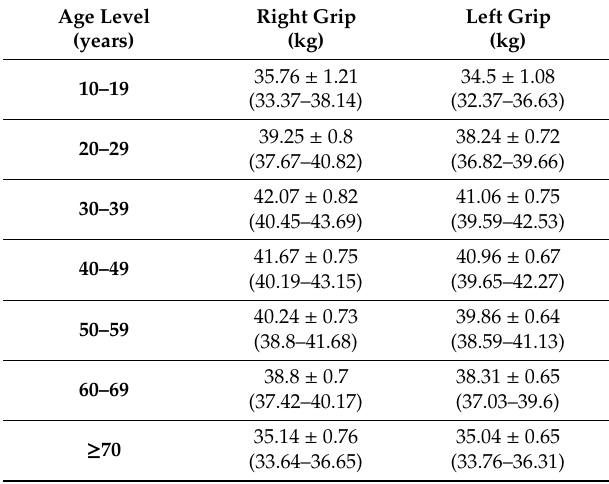
Table 3. The Normative Value of Grip Strength Adjusted for All Covariates in Male.